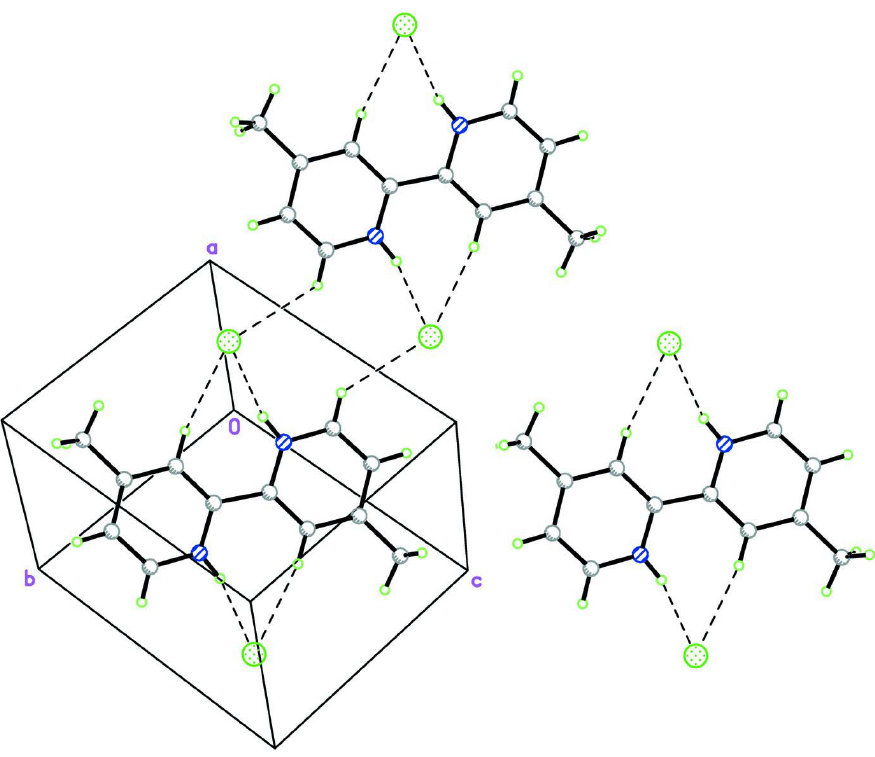
Figure 2 Packing diagram of the title compound viewed perpendicular to the (1 1 1) plane. Hydrogen bonds are indicated as dashed